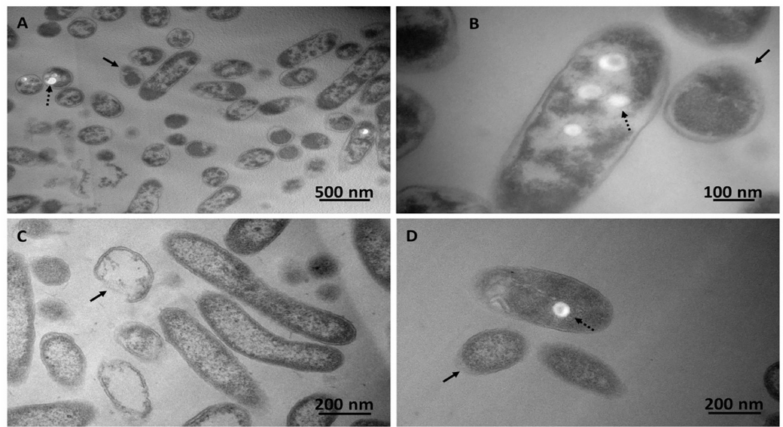
Figure 2. Transmission electron micrographs of PS27 ( A , B ) or PDMF10 ( C , D ) grown for 72-h in the presence of the mixture ethanol-octane or octane, respectively. Black arrows and dashed ones indicate cell structural features and electron transparent inclusion bodies,